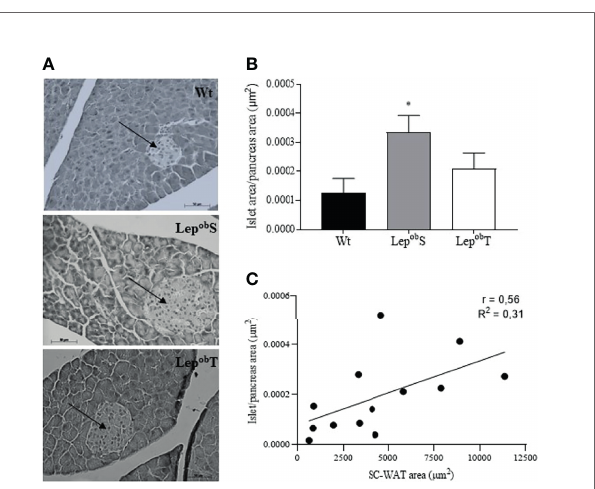
FIGURE 3 | Representative histological sections of pancreas to visualize the morphology of pancreatic islet at 400X magni fi cation (A) , pancreatic islet area to pancreas area ration (B) , and correlation between pancreatic islet area to pancreas area ratio and SC-WAT adipocytes area (C) . Wt (n = 6), Lep ob S (n = 5) and Lep ob T (n = 5). The arrows point to the pancreatic islets. Error bars indicate the SEM. *p ≤ 0.05 vs. Wt. The results were compared by the one-way ANOVA plus Tuckey post hoc